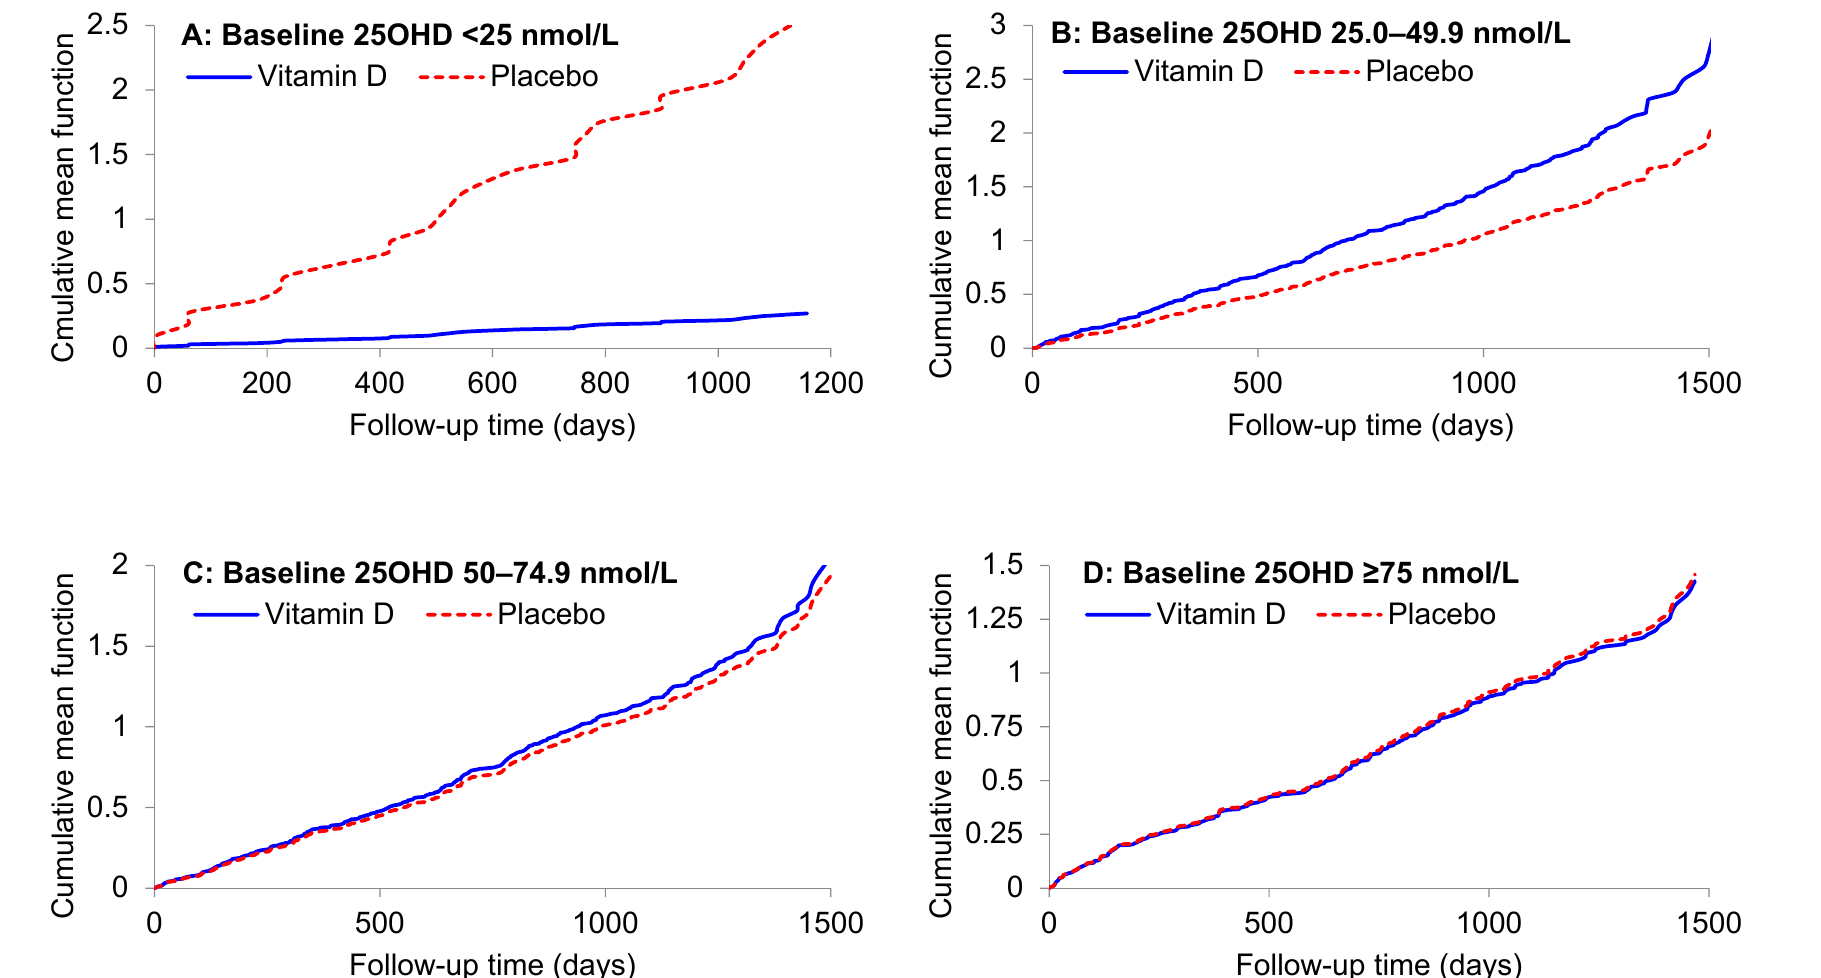
Figure 3. Mean cumulative number of exacerbations of asthma or chronic obstructive pulmonary disease during follow-up to 31 July, 2015 for deseasonalized baseline serum 25- hydroxyvitamin D subgroups (panels A to D ), by study treatment.